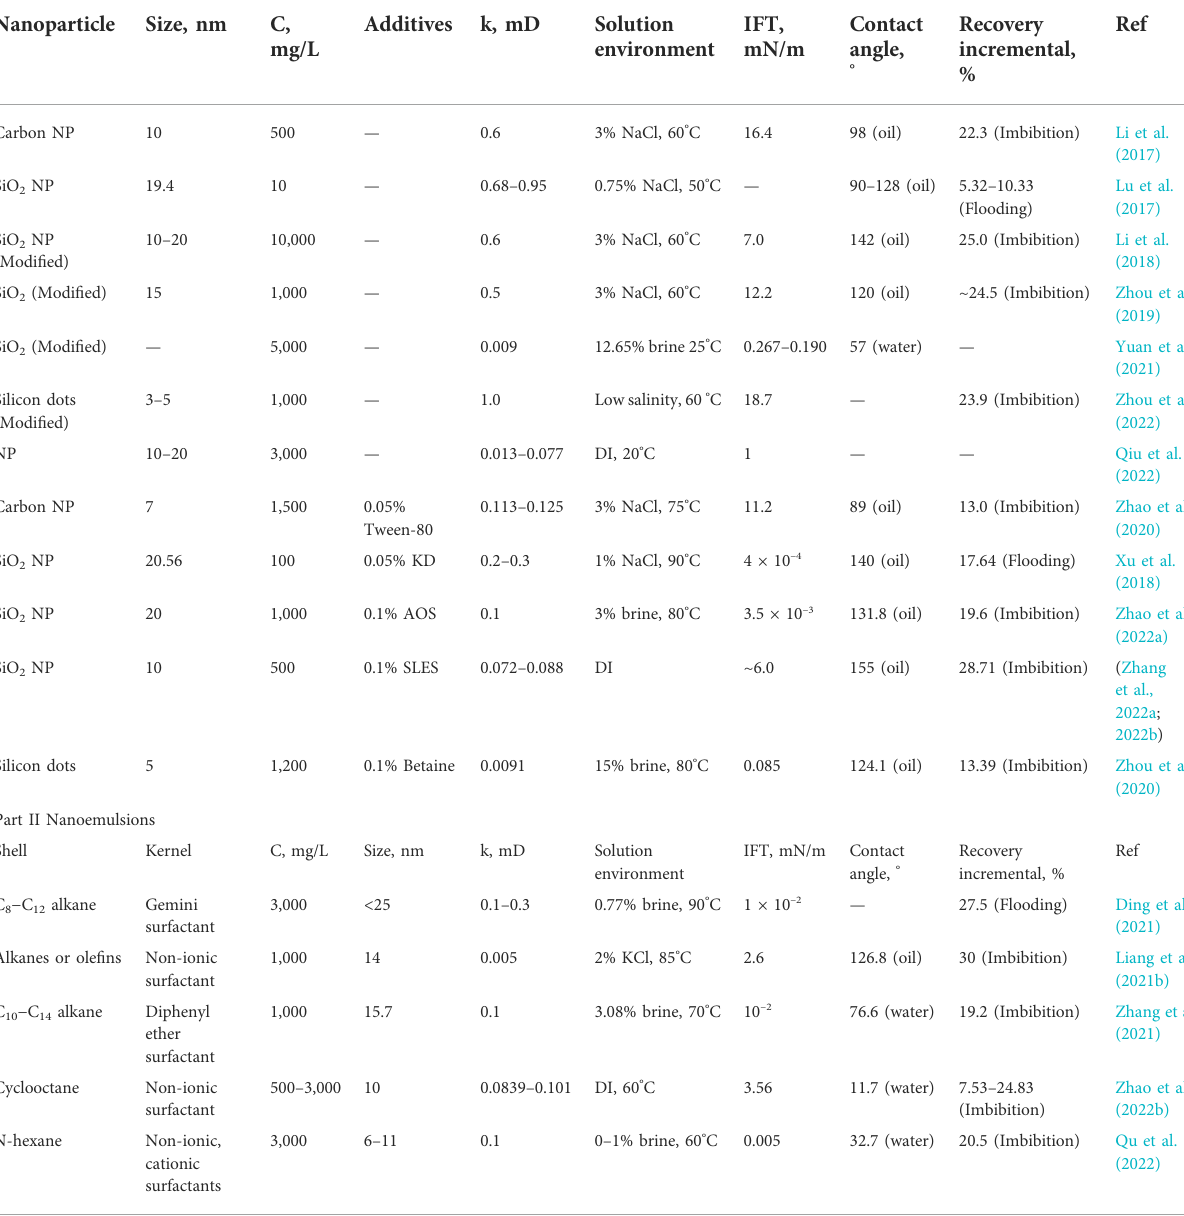
TABLE 1 Nanomaterials for tight formation EOR. Part I